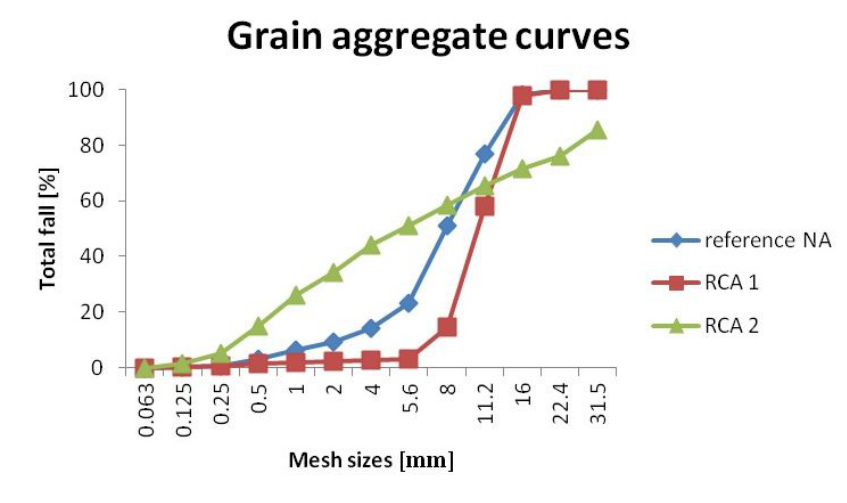
Figure 1. Graphical determination of the results of screen analysis of